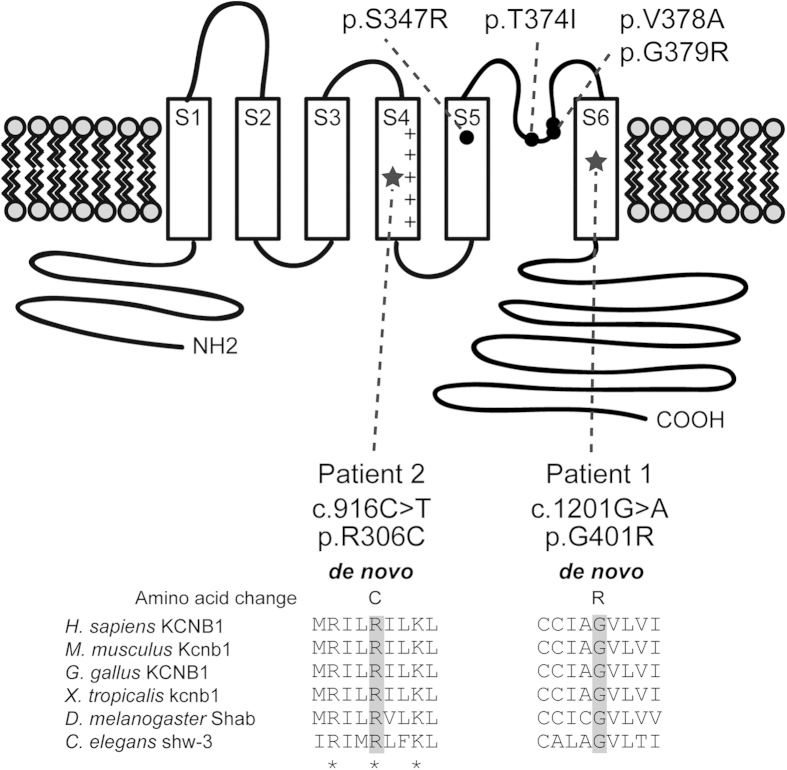
Location of KCNB1 mutations on human Kv2.1 protein obtained from UniProt (Q14721, http://www.uniprot.org/uniprot/). Four previously reported mutations16171819 (black circles) and the two mutations identified in this study (stars) are shown. The p.R306C mutation occurs at a conserved positively charged residue (asterisk) in the S4 segment, which is important for voltage sensing20. The p.G401R mutation substitutes a highly conserved glycine residue in the S6 segment, which functions as a gating hinge2. Homologous sequences were aligned using the CLUSTALW web site (http://www.genome.jp/tools/clustalw/).